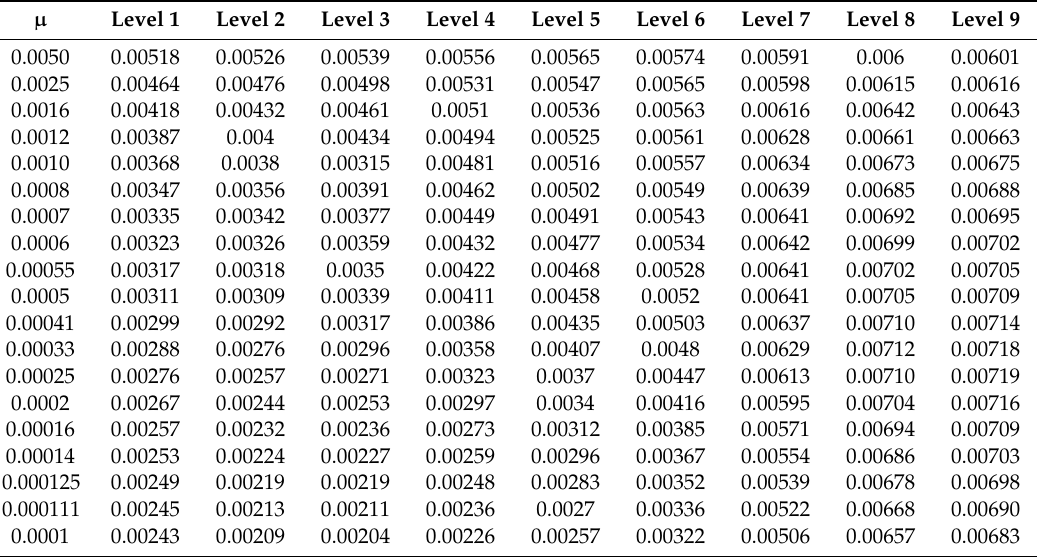
Table 3. Kinetic energy values when upper and lower walls are moving parallel.